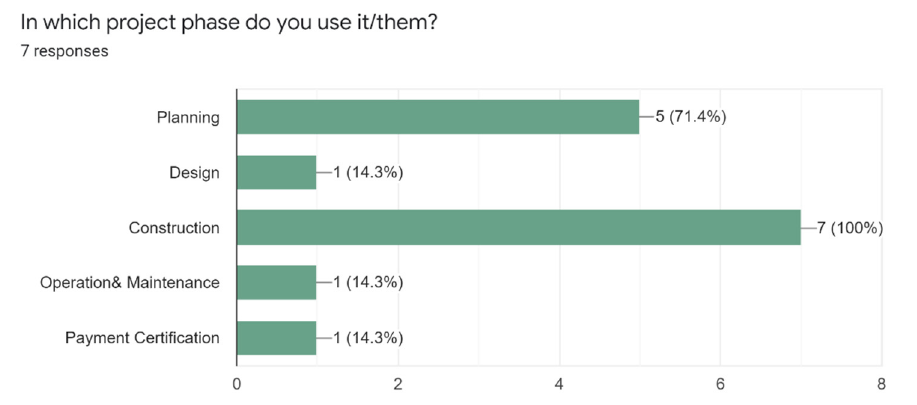
Figure 4. Summary of project phases when technologies were used.